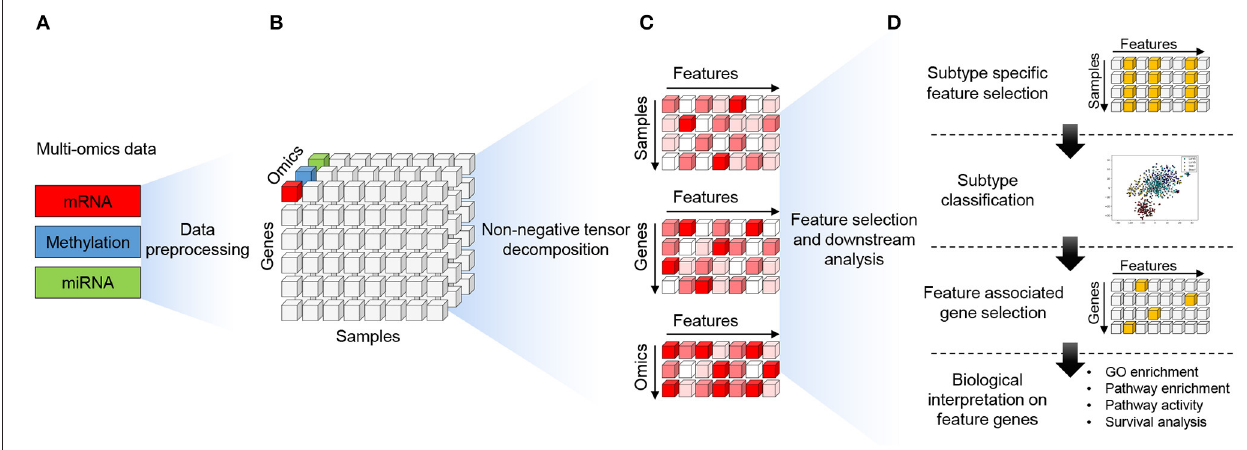
FIGURE 3 | The workflow of the MONTI framework. (A) Each omics data (gene expression, methylation, miRNA expression) is pre-processed as a two-dimensional gene-centric matrix comprised of genes and samples. (B) The omics matrices are then stacked to form a three-dimensional tensor structure (genes, samples, omics) all sharing the same genes and samples. (C) Using the PARAFAC approach, the tensor is decomposed into two-dimensional gene, patient and omics components. Here, the components share the rank features. (D) The patient component is used to select subtype-specific features using subtype-specific L1 classifiers. The selected subtype-specific features are used to build a subtype classifier model using MLP (Multi-layer perceptron). Genes associated to the subtype-specific features are then selected for biological function